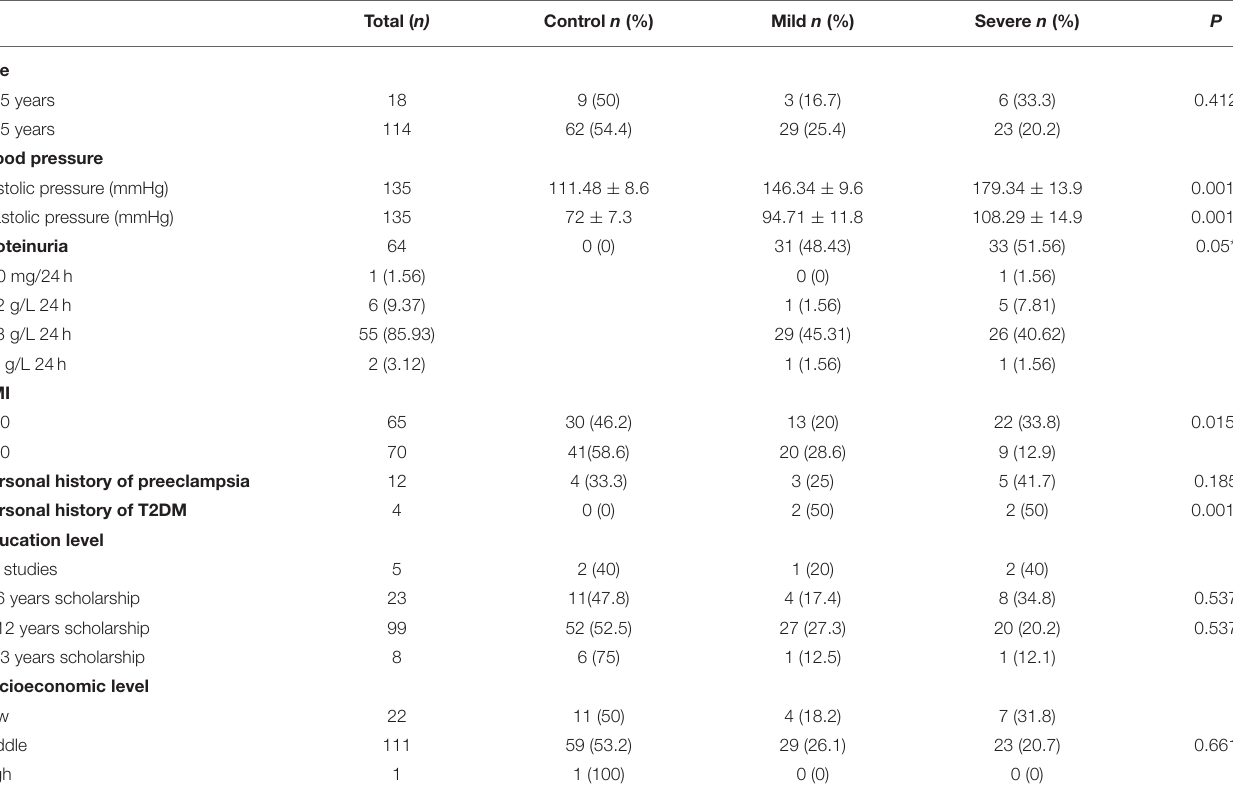
* Pearson’s χ 2 -test. The results are presented in percentages and standard